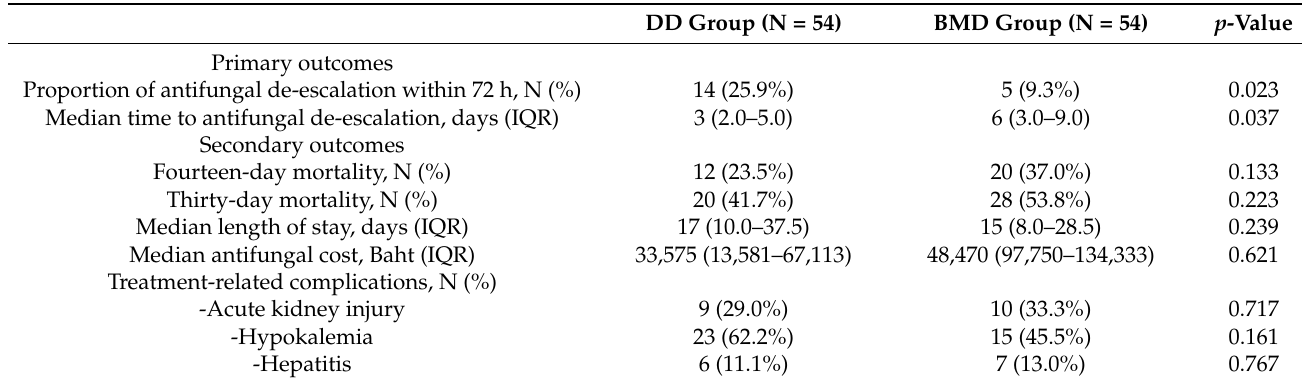
Table 2. Primary and secondary outcomes of the